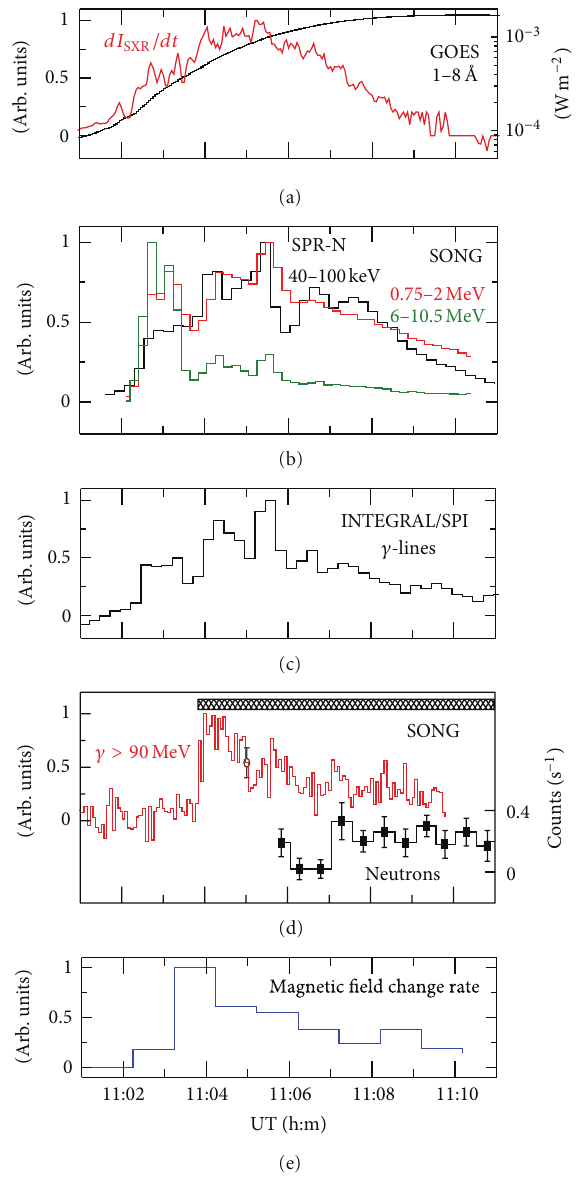
Figure 4: Normalized time profiles of selected emissions from October 28, 2003, flare: (a) soft X-ray flux and its derivative; (b) hard X-ray 40–100 keV from CORONAS-F/SPR-N (black curve); gamma-rays from CORONAS-F/SONG 0.75–2 MeV (red) and 6– 10.5MeV (green); (c) gamma-lines from INTEGRAL/SPI [46]; (d) gamma-rays > 90 MeV (red, left 𝑦 -axis) and neutrons (black, right 𝑦 -axis) from CORONAS-F/SONG; (e) magnetic field change rate [48].